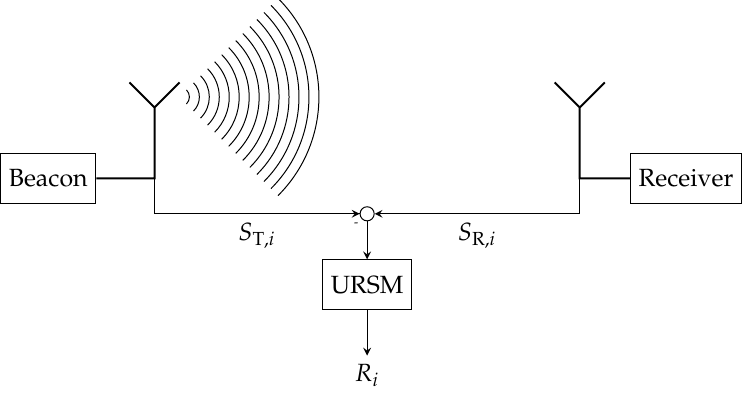
Figure 4. The underwater range sensor model (URSM) is applied to determine the range R i between the receiver unit and the i -th beacon. It maps the difference between received EM wave power S R, i and transmitted EM wave power S T, i to the range R i